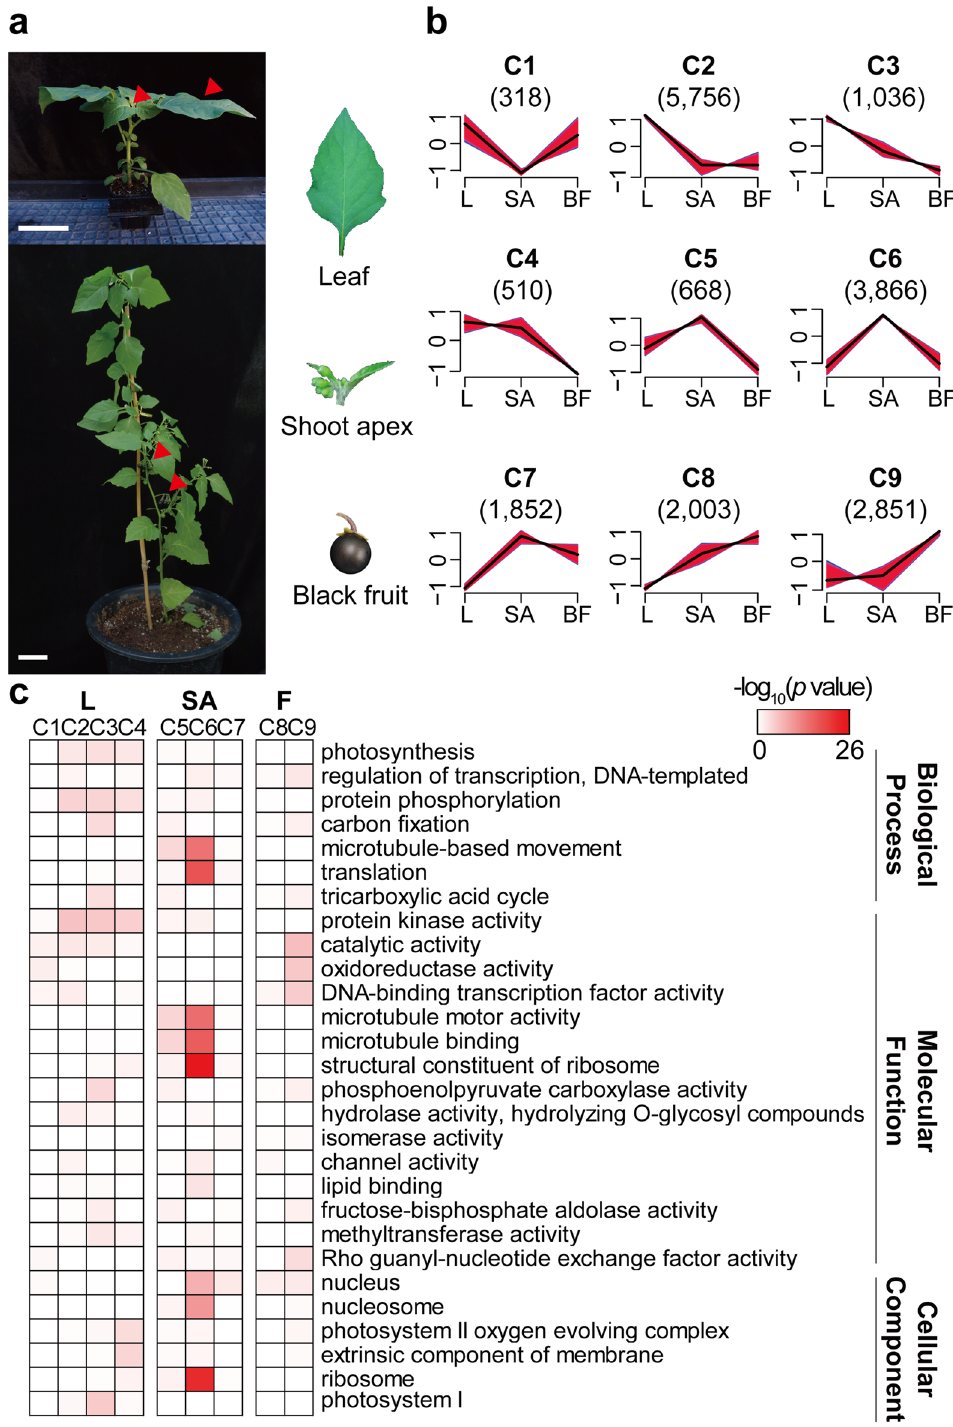
Figure 1. Unigene expression dynamics and enriched GO terms in S. nigrum DEGs. ( a ) Representative images for RNA-seq samples in S. nigrum . Red arrowheads indicate the collected positions. Scale bars, 6 cm. ( b ) Nine clusters (C1–9) of S. nigrum DEGs according to the expression patterns. The numbers in parentheses represent the number of DEGs. X-axis indicates each sample (L, leaf; SA, shoot apex; BF, black fruit) and Y-axis indicates standardized TPM values. ( c ) Enriched GO terms in each cluster. The heat-map color scale represents − log 10 ( p value) for each GO